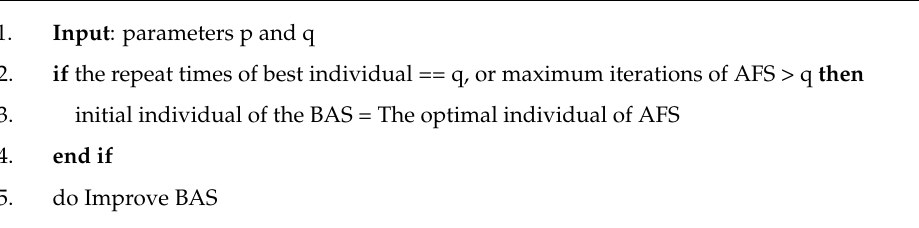
Algorithm 2. FAS algorithm termination rule pseudo